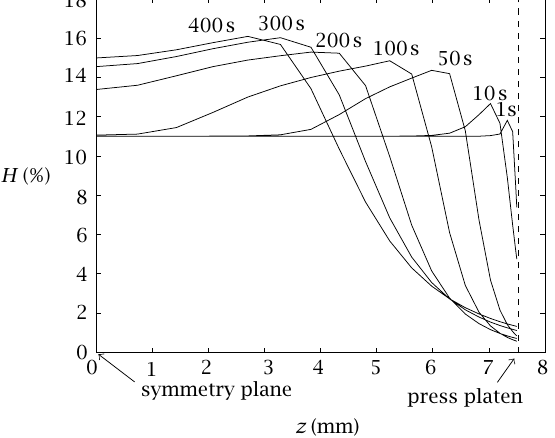
Figure 5.3 . Axial moisture content profile at r = 0.